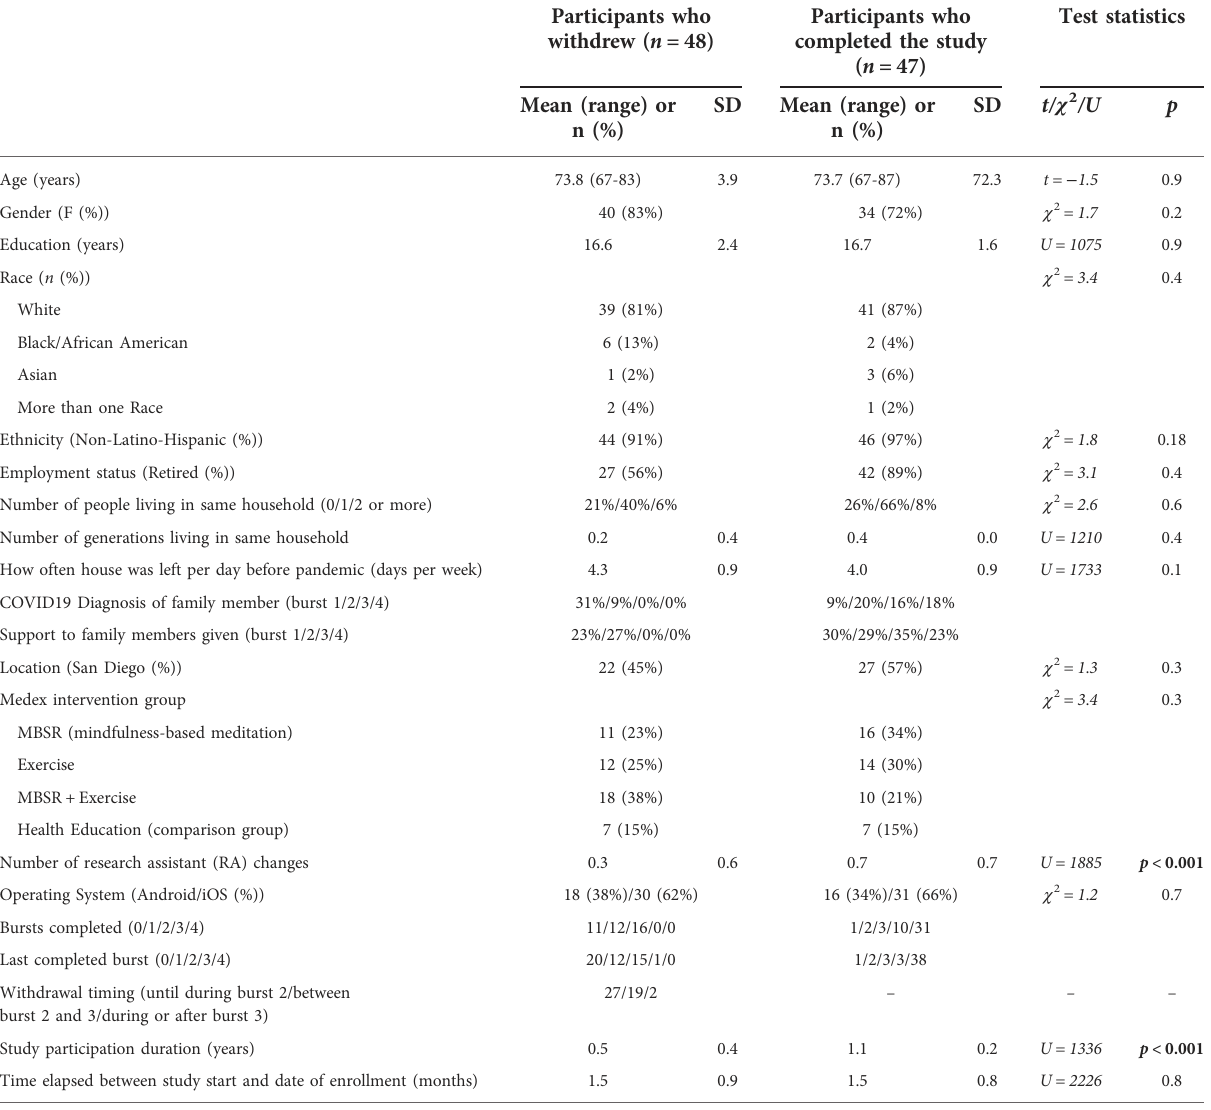
TABLE 1 Demographics of study participants who withdrew and who completed the